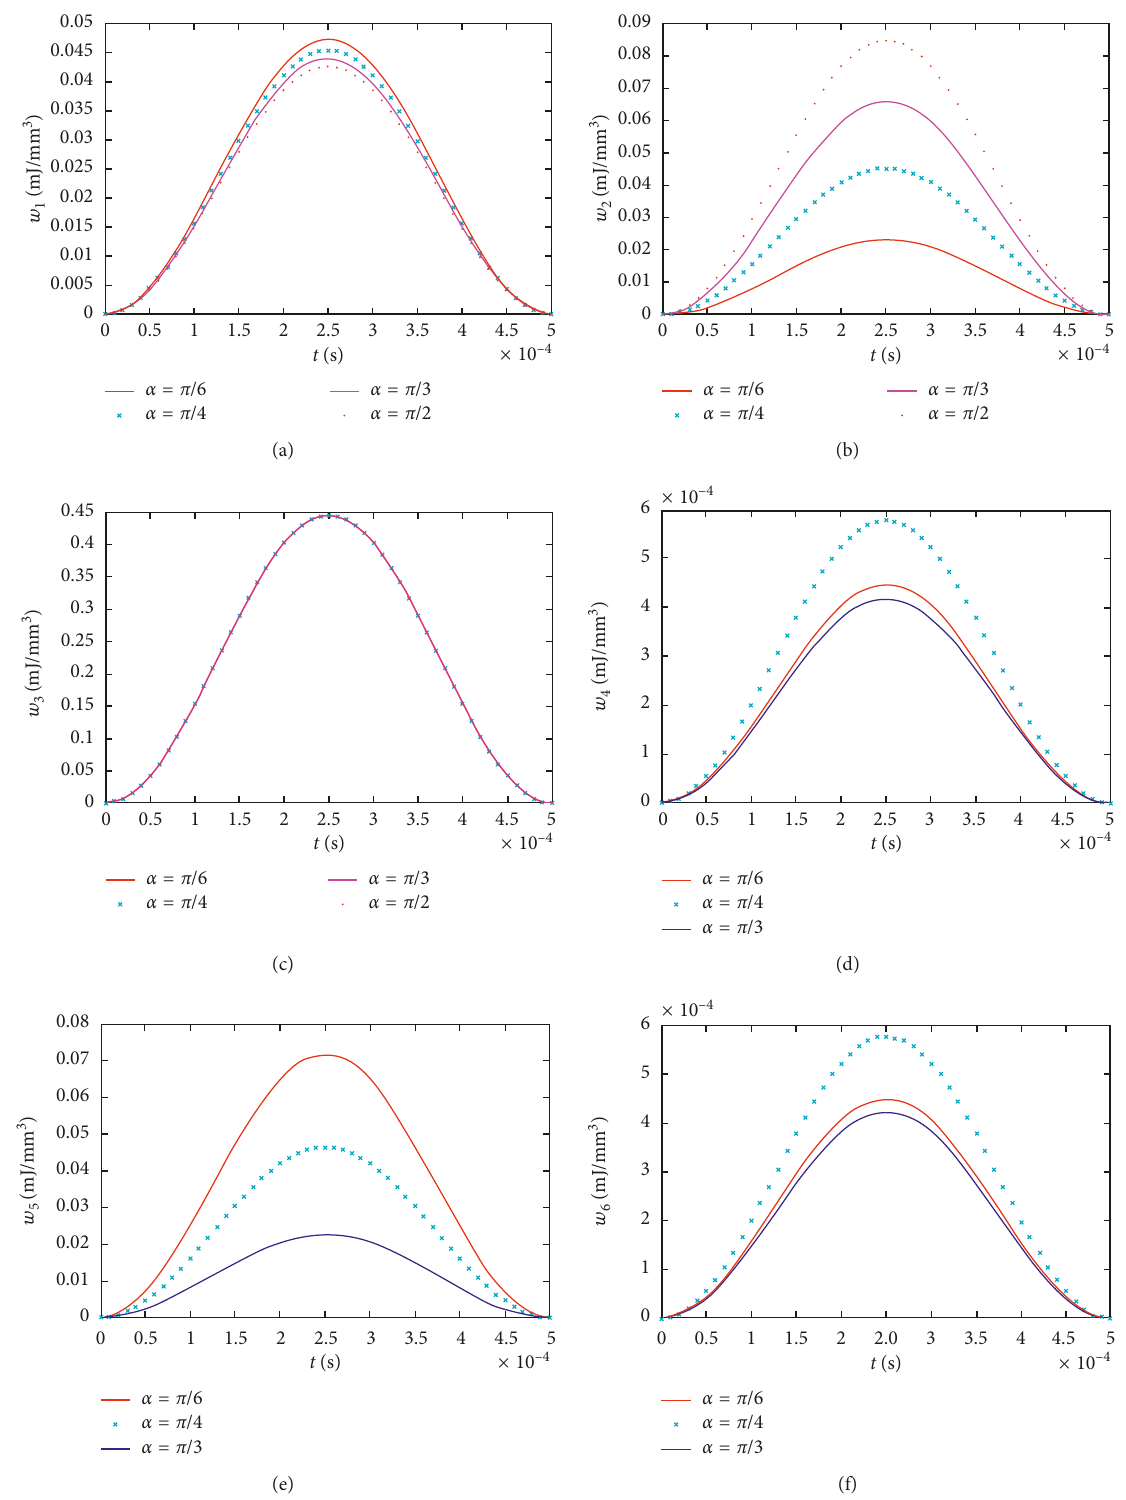
Figure 6: The influence of α on the energy density ( r the longitudinal wave u 2 . (c) The energy density by the longitudinal wave v 3 . (d) The energy density by the longitudinal wave u 1 . (e) The energy density by the flexural wave v 2 . (f) The energy density by the longitudinal wave u 3